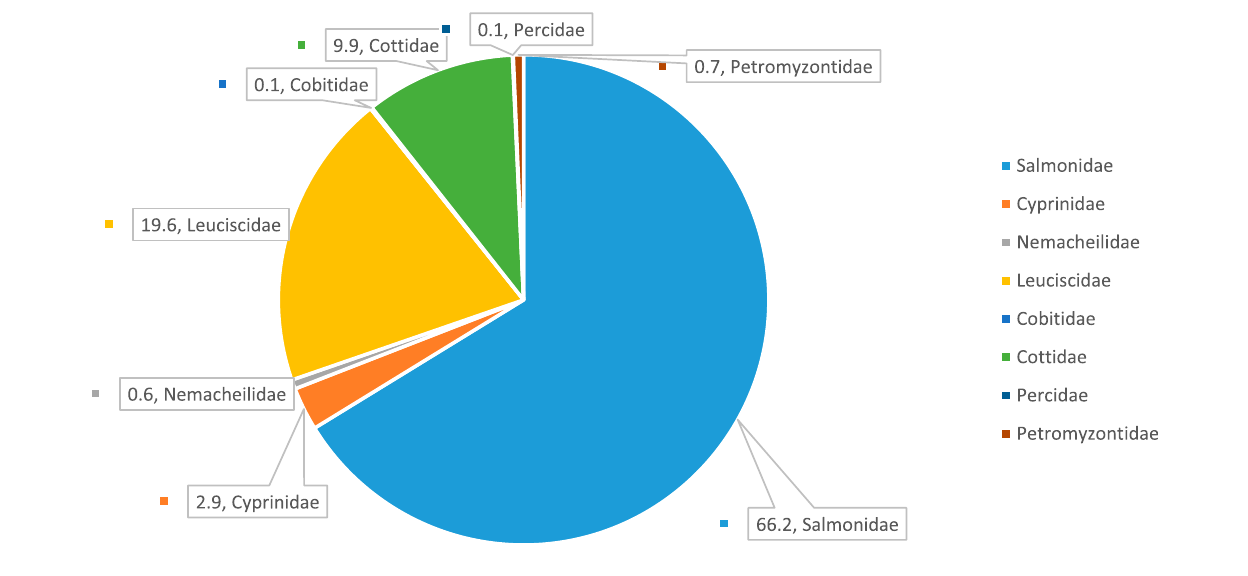
FIGURE 3 | Fish family composition % from Some ș ul Cald River.